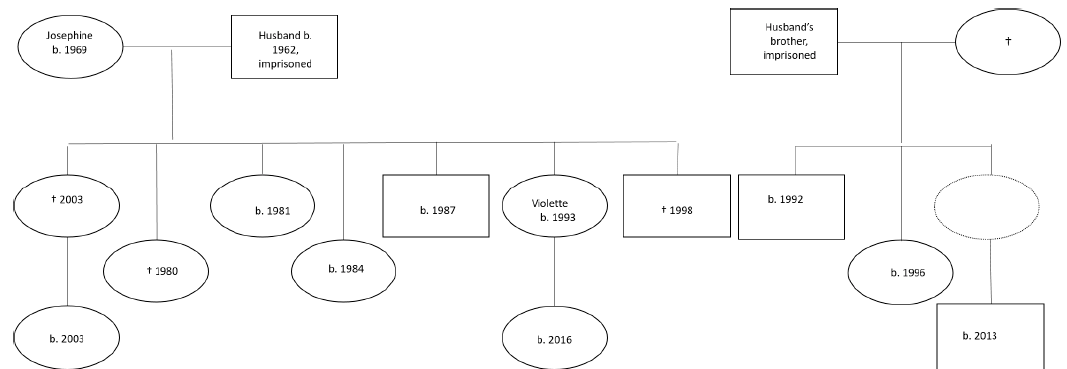
Figure 2. Family tree of Household 40.